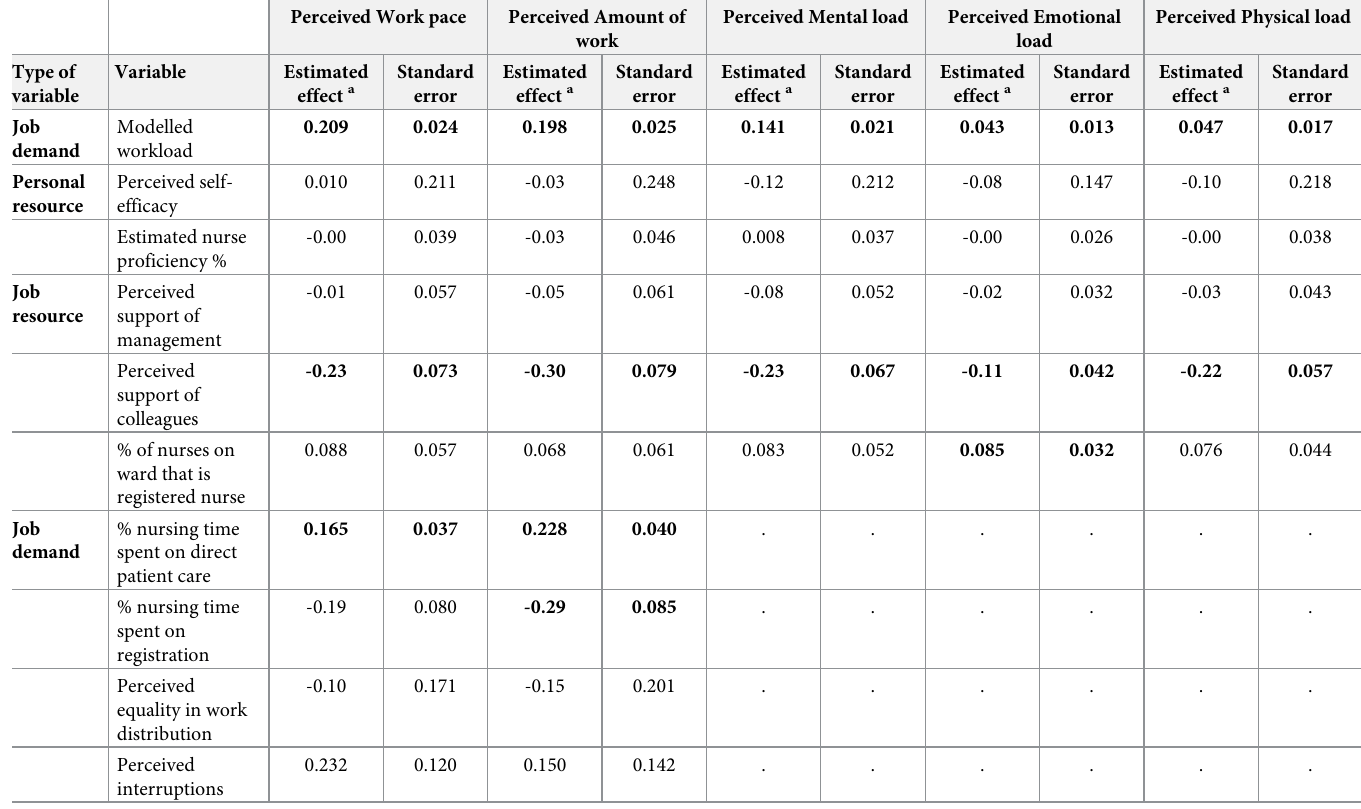
Table 2. Effects of job demands, job resources and personal resources on five outcome measures of perceived workload (range 1 to